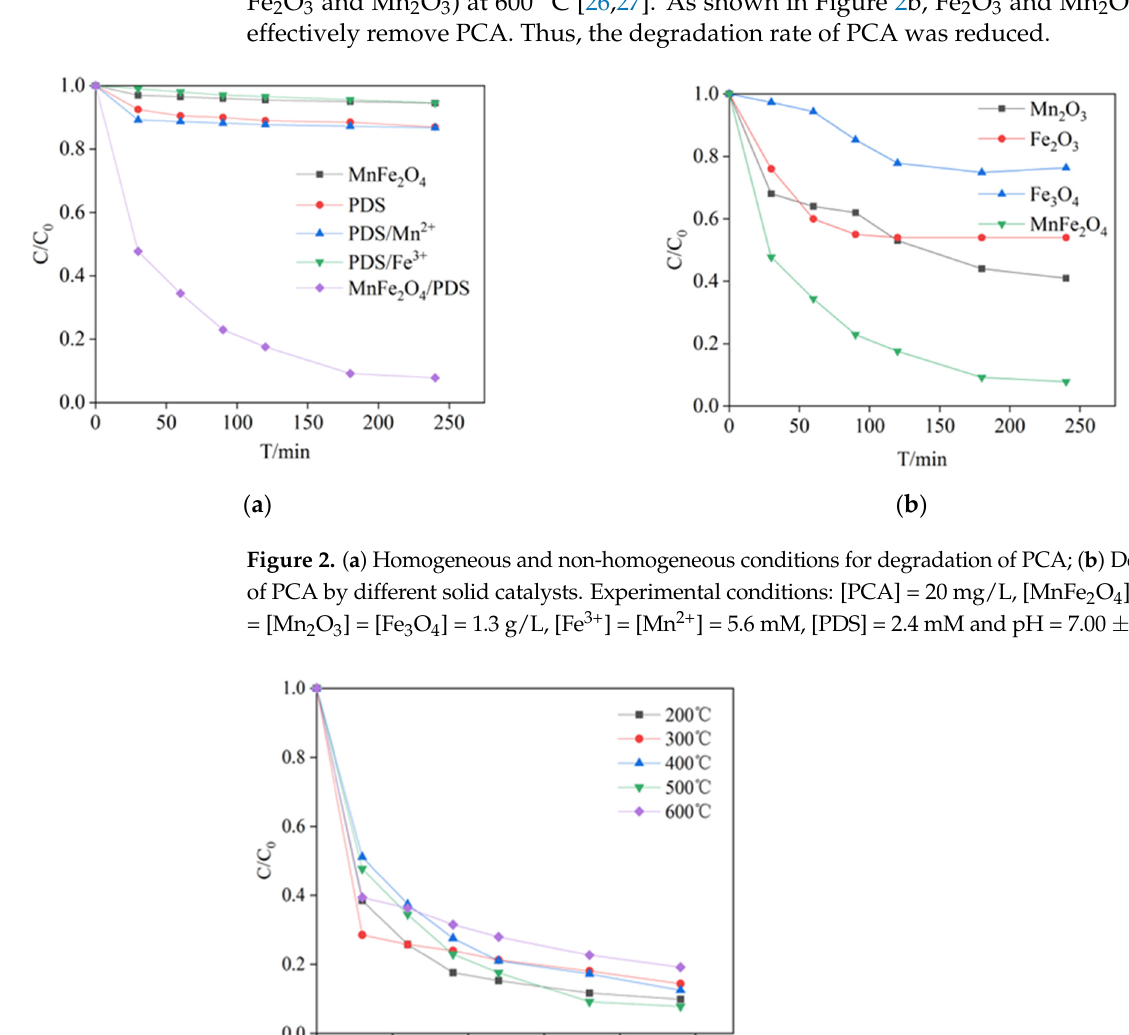
Figure 3. Effect of calcination temperatures on degradation of PCA by PDS catalyzed with MnFe 2 O 4 . Experimental conditions: [PCA] = 20 mg/L, pH = 7.00 ± 0.02, [PDS] = 2.4 mM, [MnFe 2 O 4 ] = 1.3 g/L, and T = 25 °C.